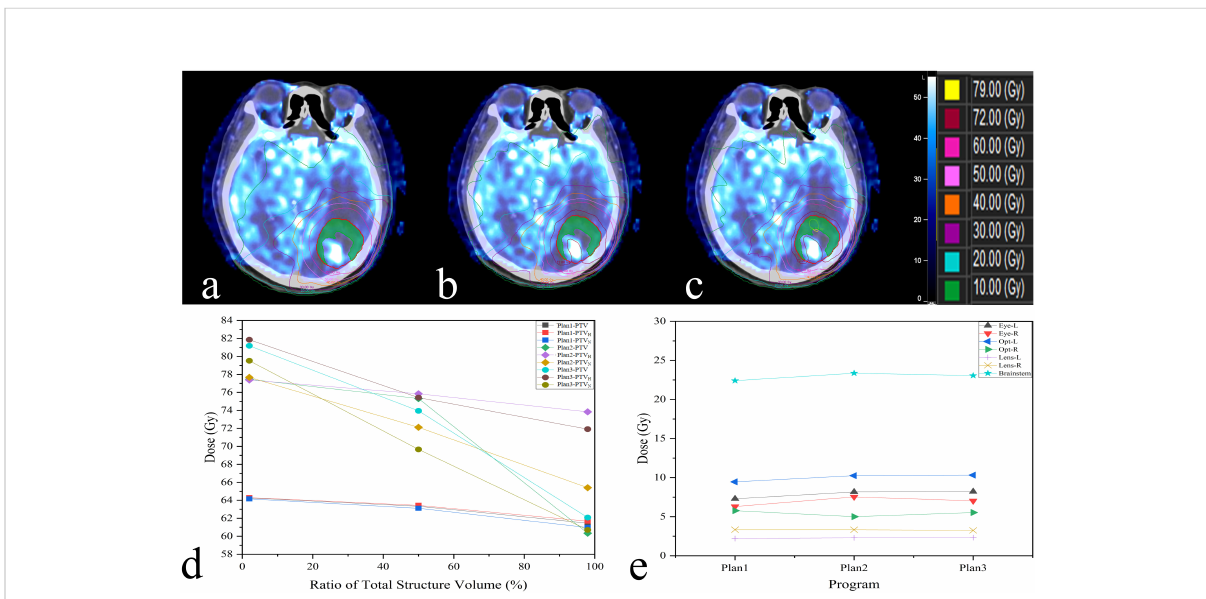
FIGURE 4 The difference among three plans is shown in this example ( A :Plan1; B :Plan2; C :Plan3);. Display on axial slices for dose painting plan showing prescribed 72 Gy around PTV H (green). The dosimetric indices D 2%, D 98% , Dmean and the dose received by OARs are also revealed in (D, E) .